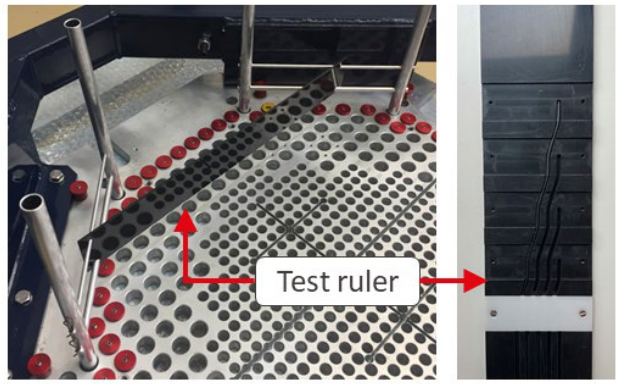
Fig. 5. Mock-up mechanical structure to support a test ruler.